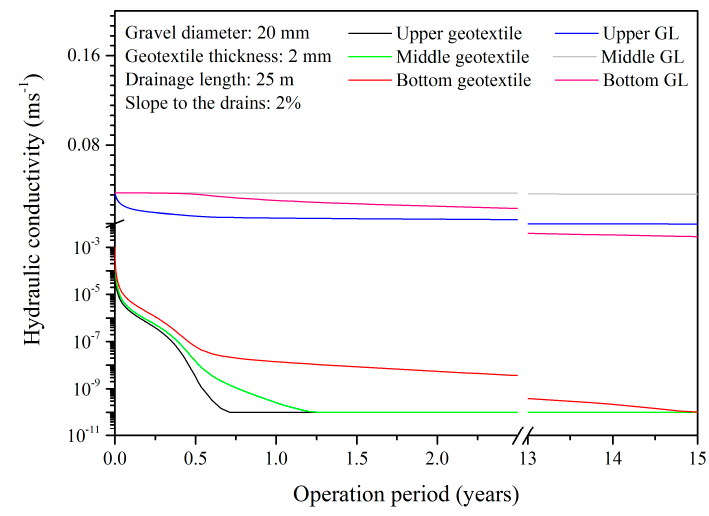
Figure 5. Decrease in hydraulic conductivity in the geotextile and gravel (GL) layers of the leachate collection system (LCS) over time.